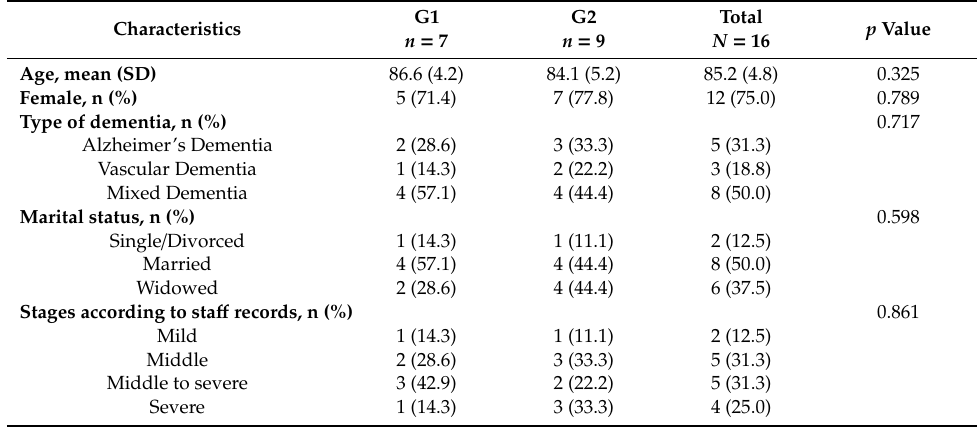
Table 2. Participant demographics including age, gender, type of dementia, marital status, stage of dementia, cognitive functions, wheelchair use, MMSE score, and length of stay in facility. No statistical di ff erence was found between demographic characteristics of two groups of